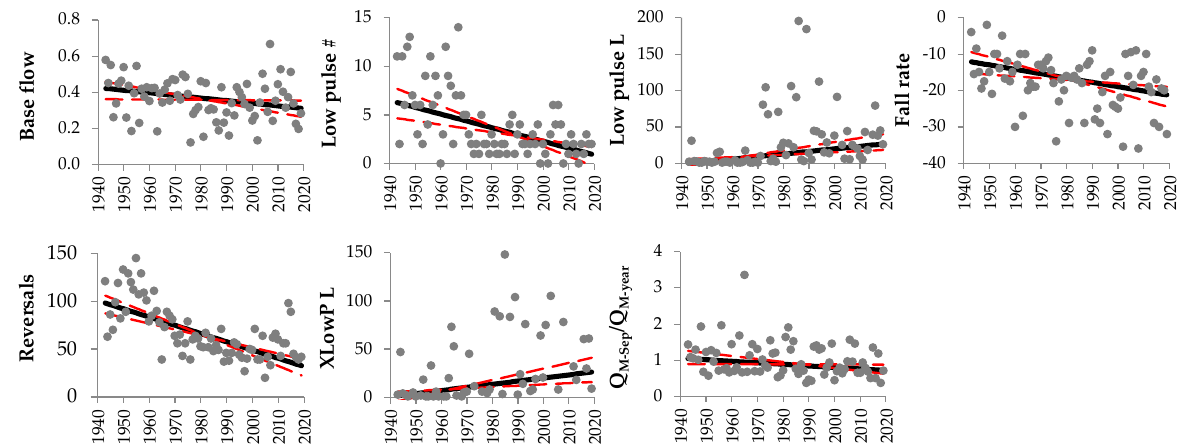
Figure 2. Data and Sen’s slope estimates of the hydrological parameters concerning the Lake Maggiore outflows recorded dur-